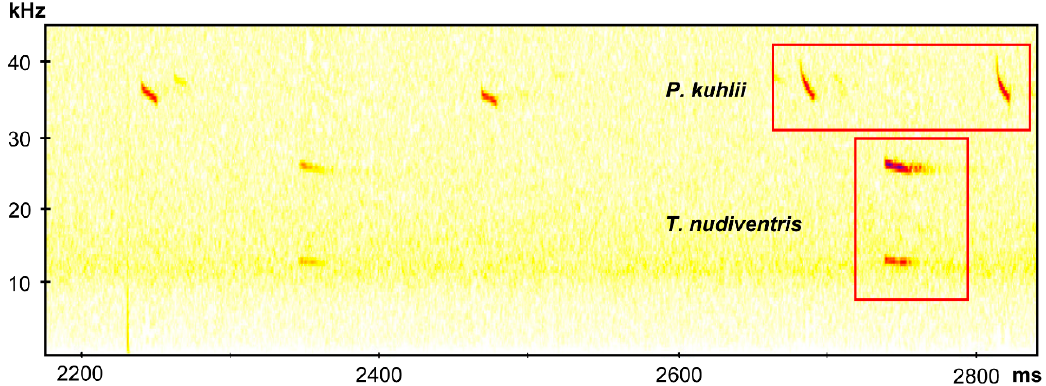
Figure 2. Results of acoustic analyses. Examples of the recorded sonograms for Pipistrellus kulli (higher frequency) and Taphozous nudiventris (lower frequency). These and other records are available in Morphobank (P3514); see Table S1 for more details. Table 1. Morphological measurements of specimens. Information about species (Sp), sex (S), length of forearm (FA), fifth finger (D5), third finger (D3), thumb (D1), lower leg (Tib), hind foot (HF), 1st and 2nd phalange of the 4th finger (P4.1 and P4.2), and the 2nd and 3rd phalanges of the 3rd finger (P3.2 and P3.3) are also given. Hs stands for H. savii , Ms for M. schreibersii , Pa for P. austriacus , and Tn for T. nudiventris . Sp Code